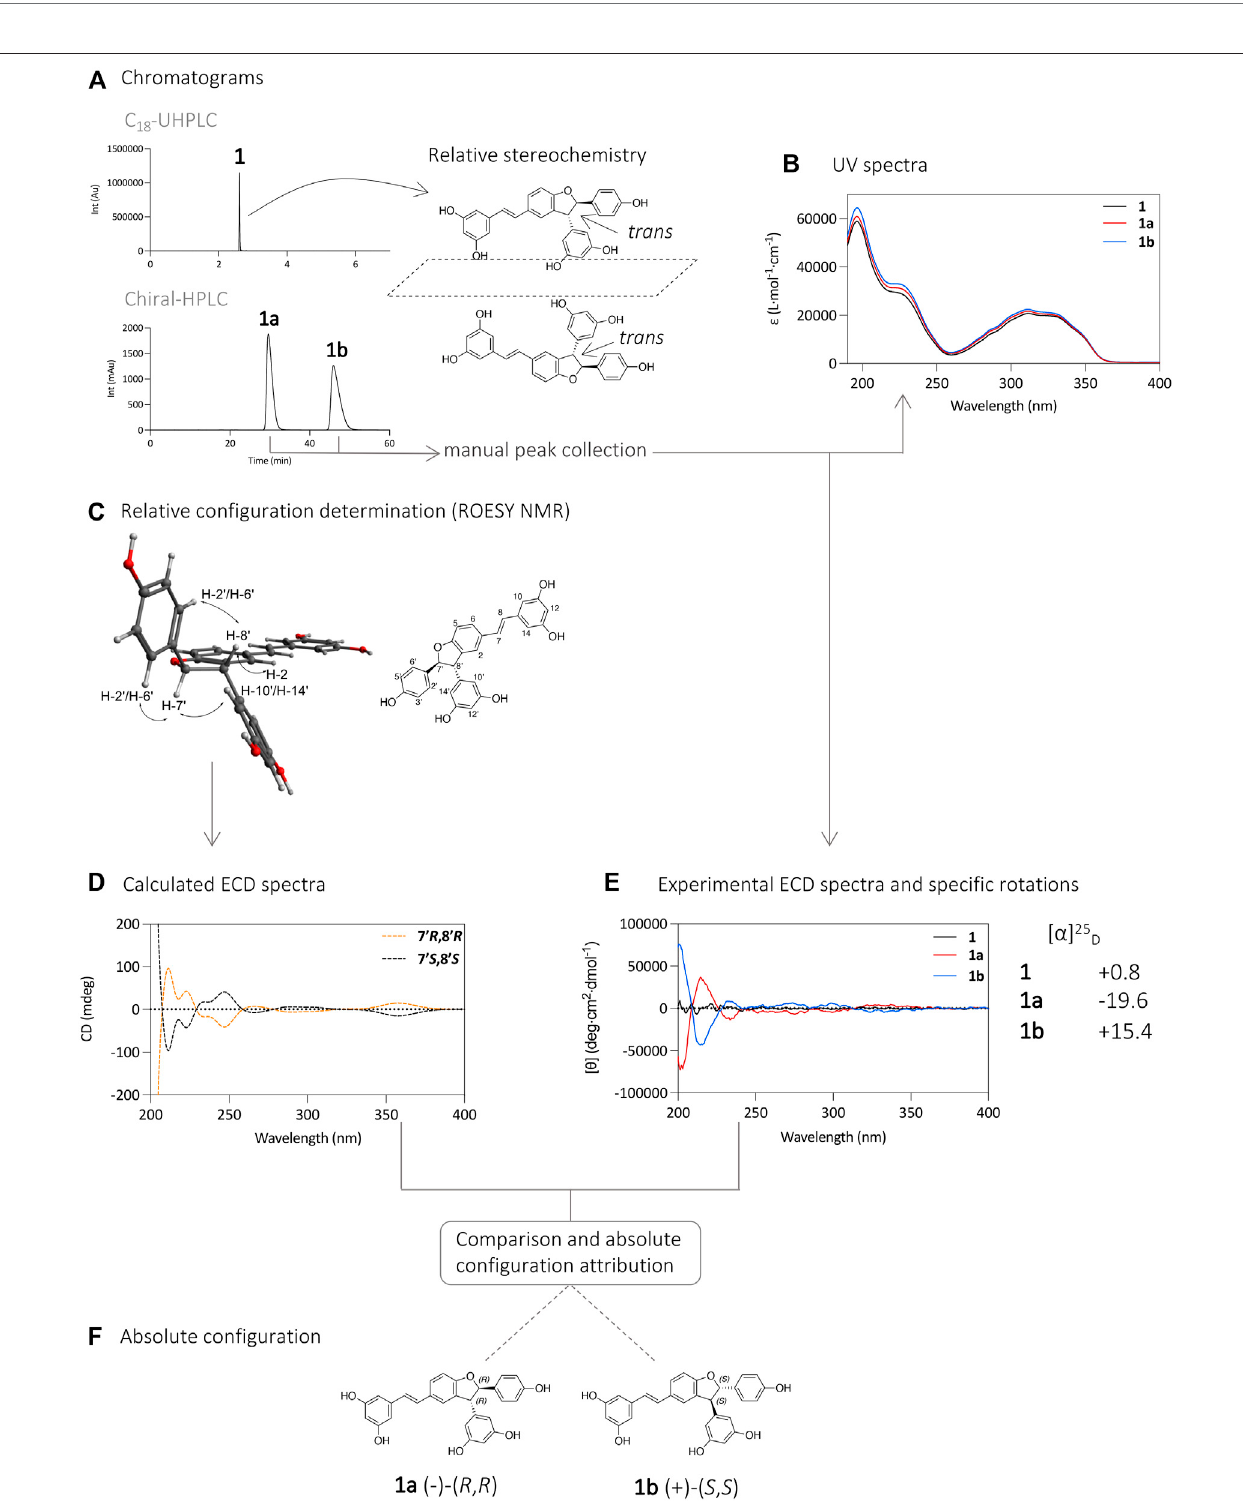
FIGURE 2 | (A) UHPLC-PDA analysis of 1 using an Acquity UPLC BEH C 18 column (50 × 2.1 mm i. d., 1.7 µm; Waters), and separation of its enantiomers 1a and 1b on HPLC-PDA using an Chiralpak ® IB N-5 column (250 × 4.6 mm i. d., 5 µm; Daicel). (B) UV spectra of compounds 1, 1a , and 1b . (C) Relative con fi guration determination by ROESY NMR experiment. The spectrum with the correlations is presented in Supplementary Figure S1 . (D) Calculated ECD spectra. (E) ECD and speci fi c rotation ([ α ] D ) analysis of compounds 1, 1a , and 1b . (F) Determination of the absolute con fi guration of compounds 1a and 1b .